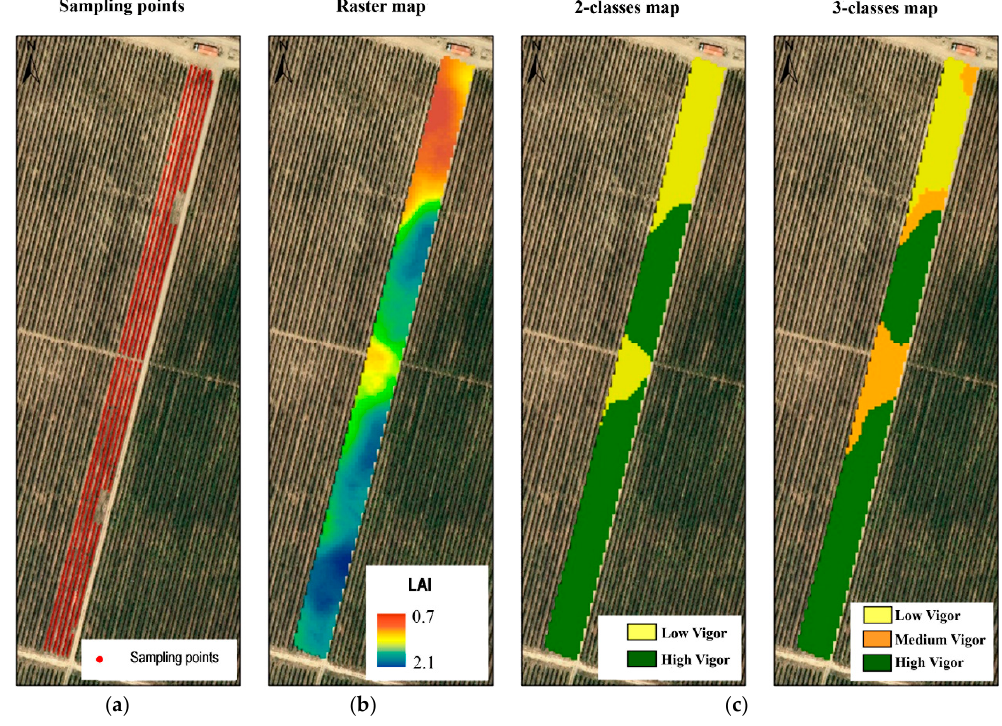
Figure 8. ( a ) Sampling points, ( b ) LAI raster (interpolated) map and ( c ) LAI classified maps (2 classes and 3 classes) in an area of 0.70 ha within a plot in a vineyard.